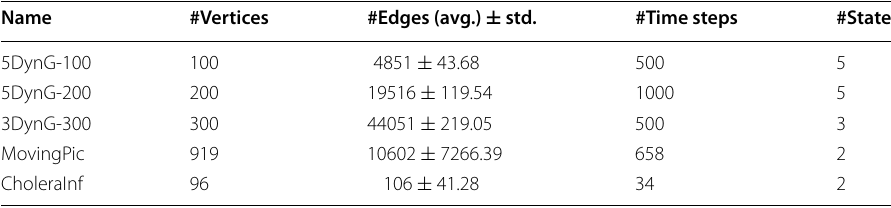
Table 1 Statistics of each dataset used in this paper Name #Edges (avg.)